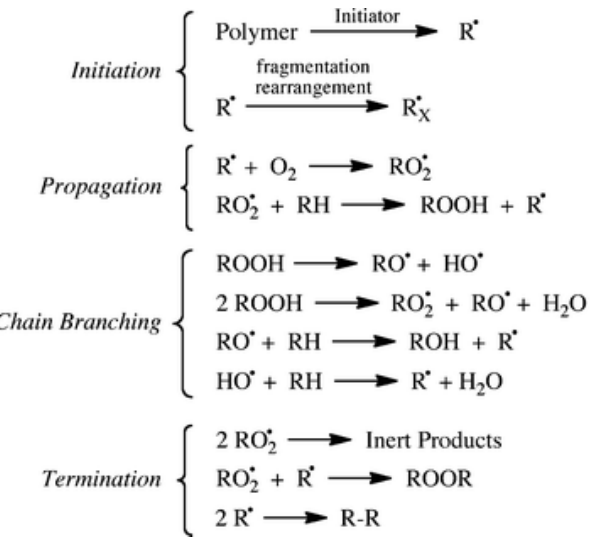
Figure 6. Simplified autoxidation scheme. Reprinted with permission from [56].